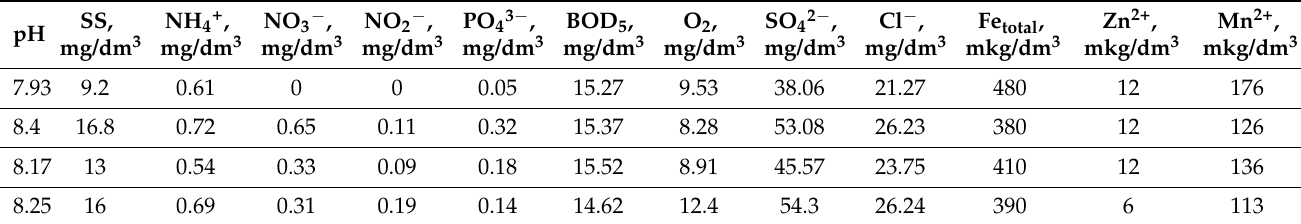
Table 1. Fragment of the results for the chemical parameters of water